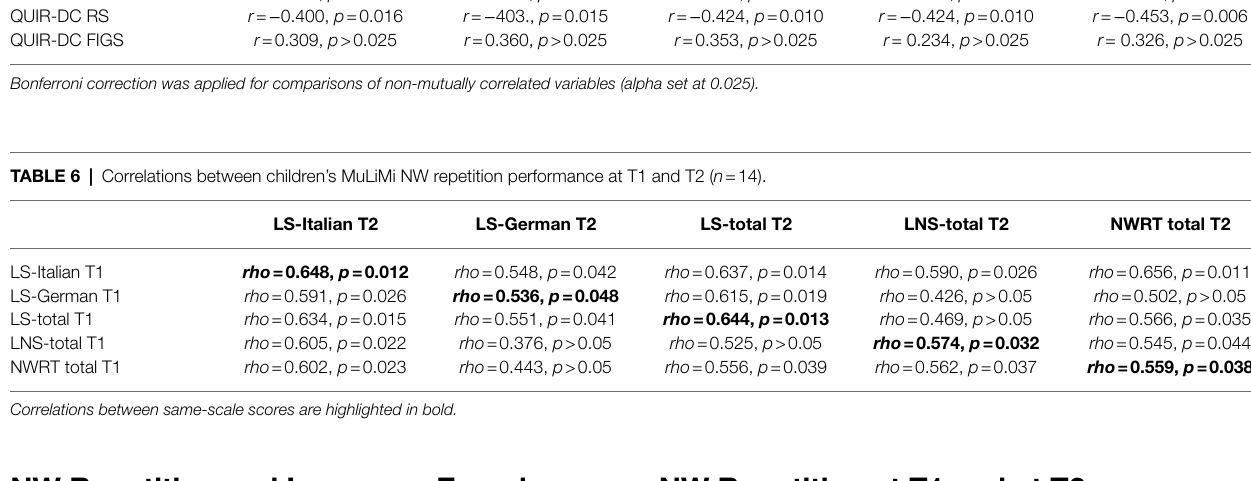
TABLE 5 | Correlations between children’s MuLiMi NW repetition performance at T1 and scores from the parental questionnaire (QUIR-DC, n = 36), GS (general score), RS (risk score), and FIGS (family input general score). LS-Italian LS-German LS-total LNS-total NWRT total